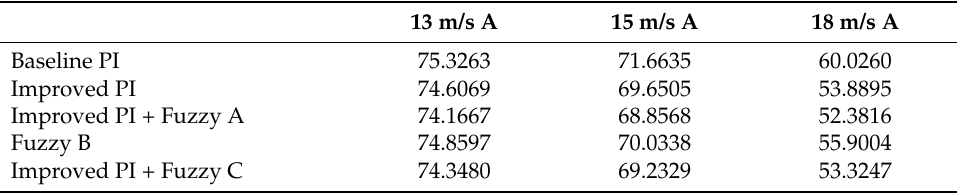
Table 11. Mechanical loads index, MI (MN · m).